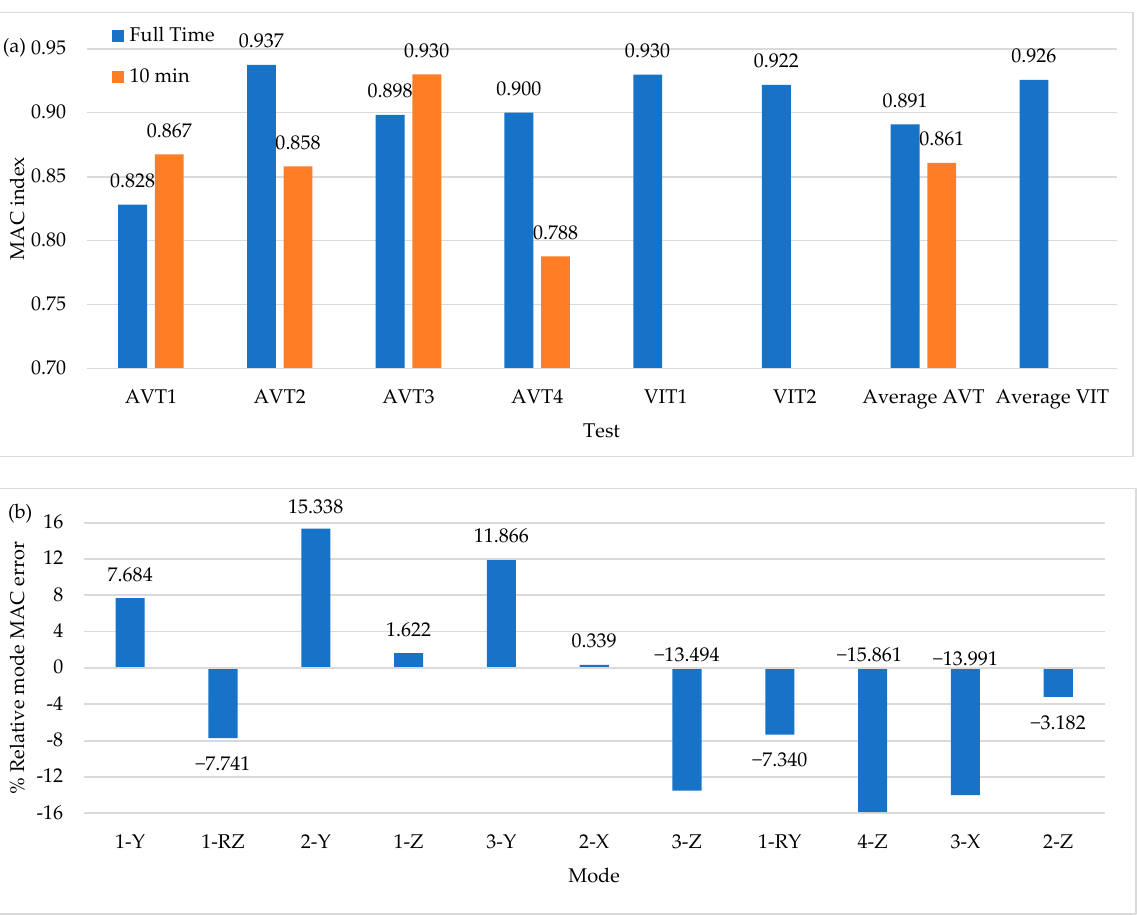
Figure 22. ( a ) Average values of MAC index ( b ) Percentage of relative MAC index error of AVTs with 10 min time series. Table 4. Representative cost of dynamic tests per day (8 h).